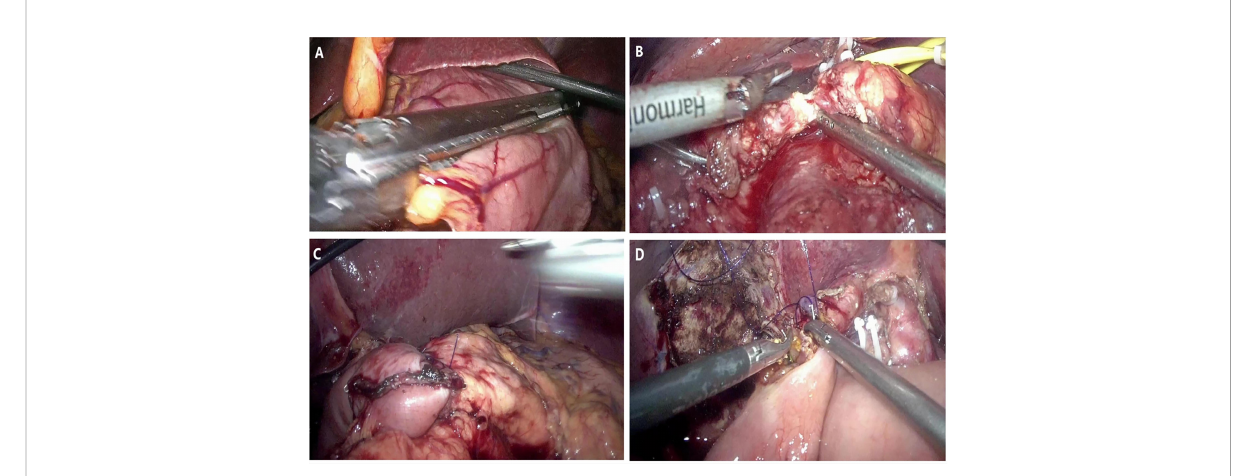
FIGURE 4 Representative photographs of the LPD: (A) Transection of stomach. (B) Transection of pancreas. (C) Pancreaticojejunostomy anastomosis. (D) Hepaticojejunostomy